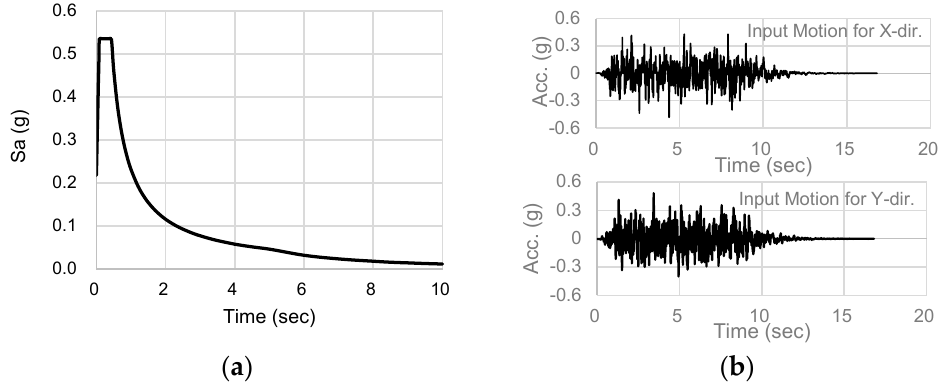
Figure 2. Arti fi cial accelerograms: ( a ) design spectrum; ( b ) waveform. Figure 2. Artificial accelerograms: ( a ) design spectrum; ( b ) waveform. Table 3. Test procedure and smartphone measurement. Table 3. Test procedure and smartphone